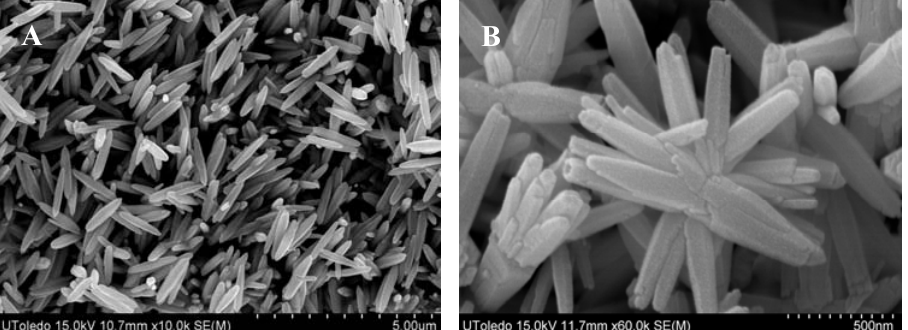
Figure 5. SEM images of the particles produced by reflux boiling of aqueous solution containing 0.034 mol/L zinc nitrate and 0.013 mol/L hexamine for 40 min. with: ( A ) 4.5 vol.% ethylene glycol and ( B ) ethanol.